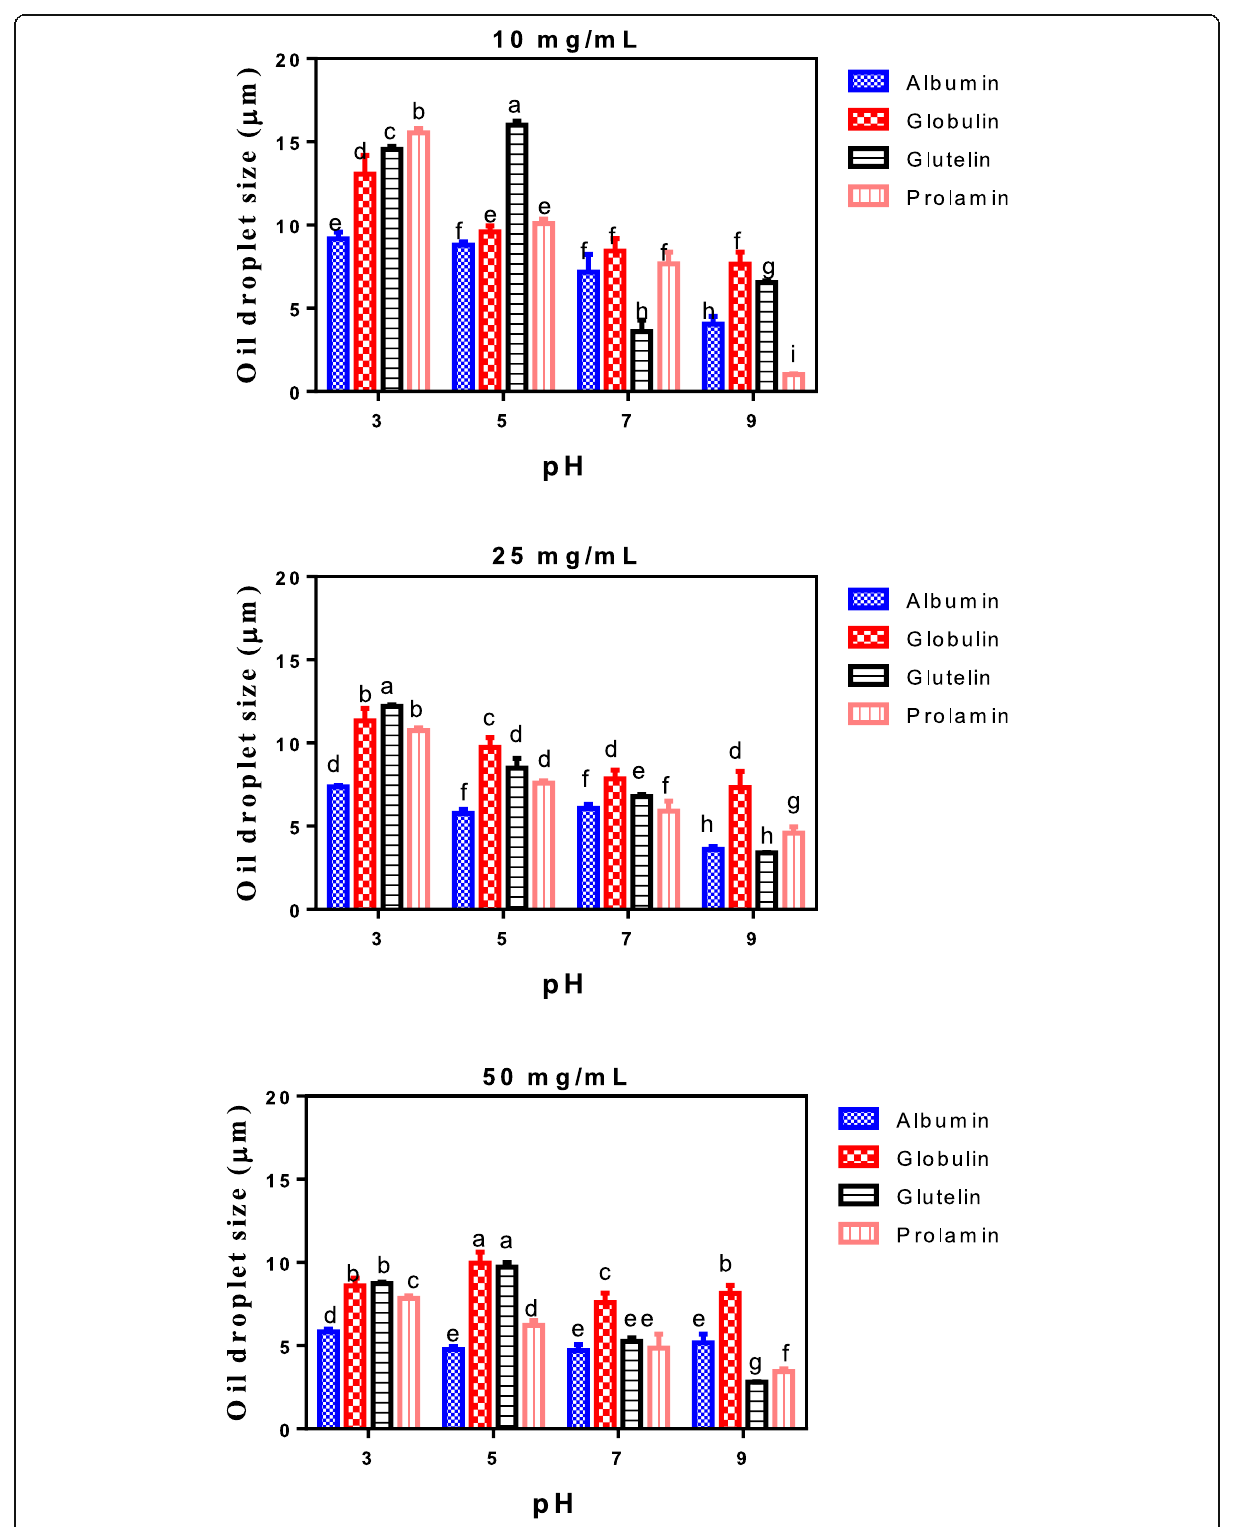
Fig. 8 Effect of pH and sample protein concentration on emulsion capacity of sesame protein